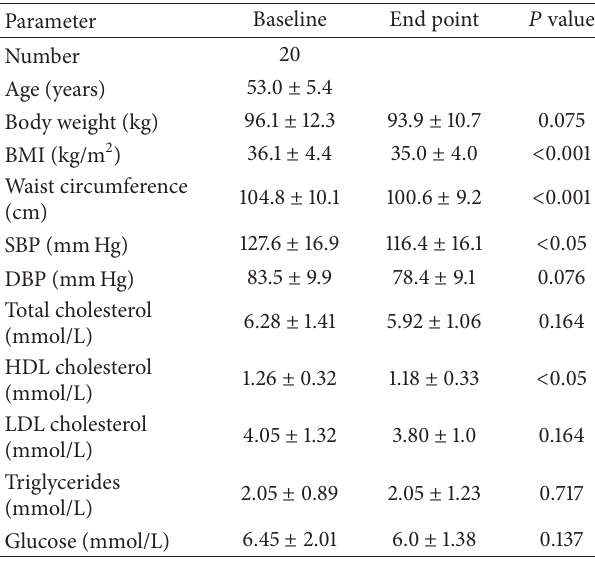
Table 1: Anthropometric and biochemical